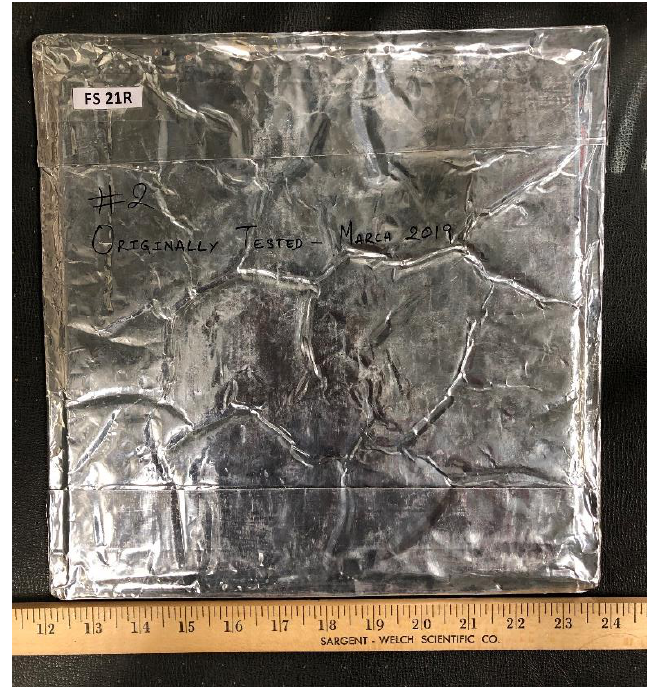
Figure 2. PCM FS21R.